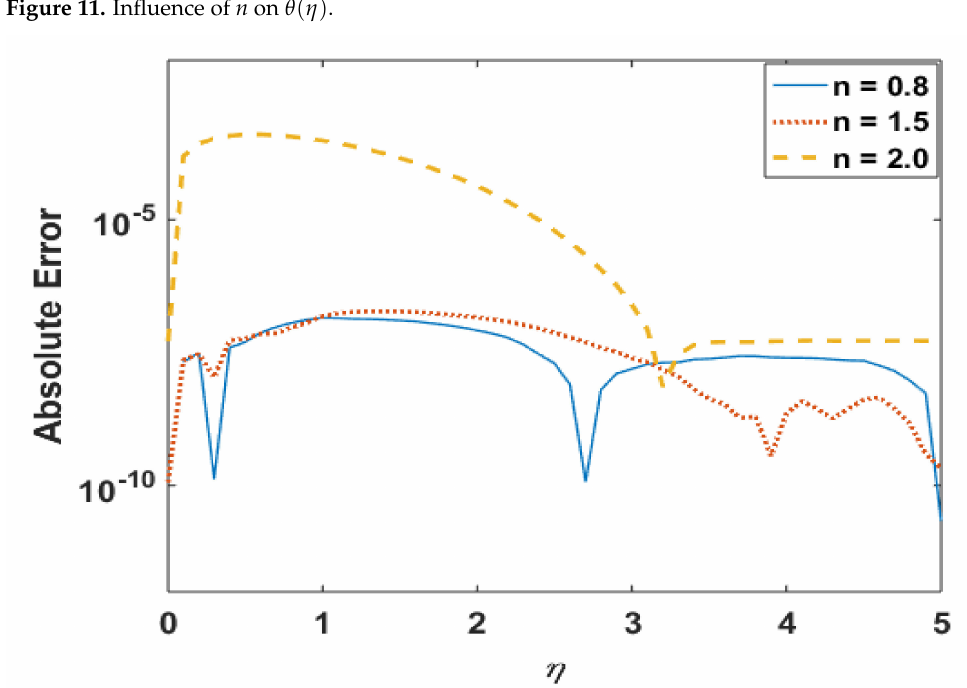
Figure 12. Absolute error in θ ( η ) for different